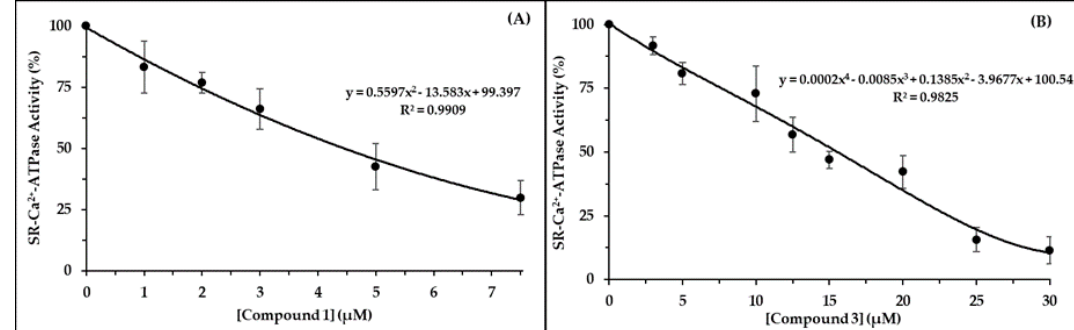
Figure 3. Inhibition of Ca 2 + -ATPase activity by gold compounds 1 ( A ) and 3 ( B ). Experiments performed in the same conditions as Figure 2 assays.